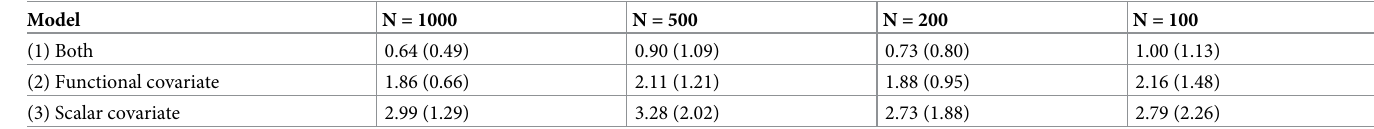
Table 1. Mean squared errors (MSE) across three different models. Different sample sizes are 1000, 500, 200, and 100, respectively. Corresponding standard deviations are recorded in parentheses. Model